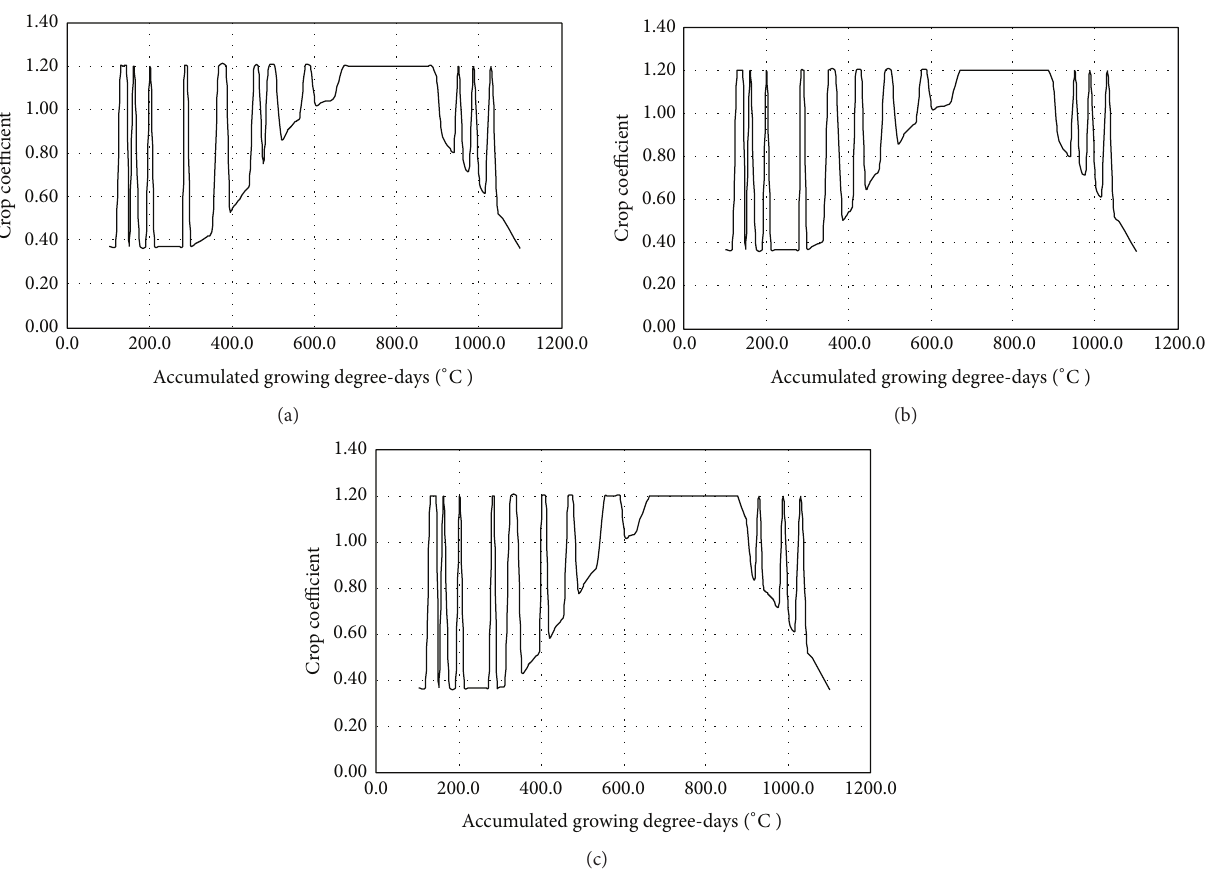
Figure 1: Crop coefficient curve for bean crop sown in the following soil tillage systems treatments: (a) revolving hoe, (b) disk ploughing, and (c) chisel ploughing, in Campinas city, S˜ao Paulo state, Brazil.